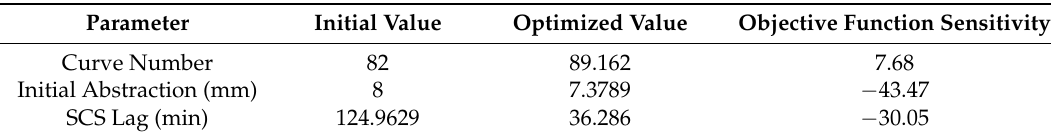
Table 4. Settings before and after calibration Add units.